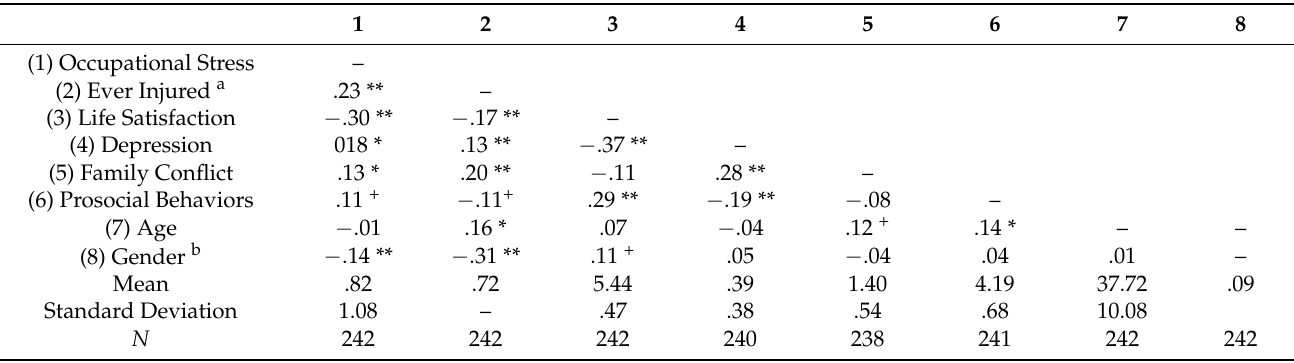
Table 2. Bivariate correlations and descriptive statistics for main study and control variables.